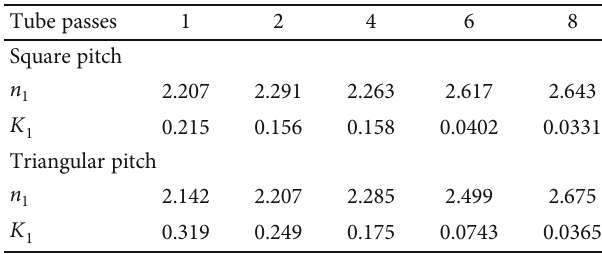
and K for use in equation (10) 1 1